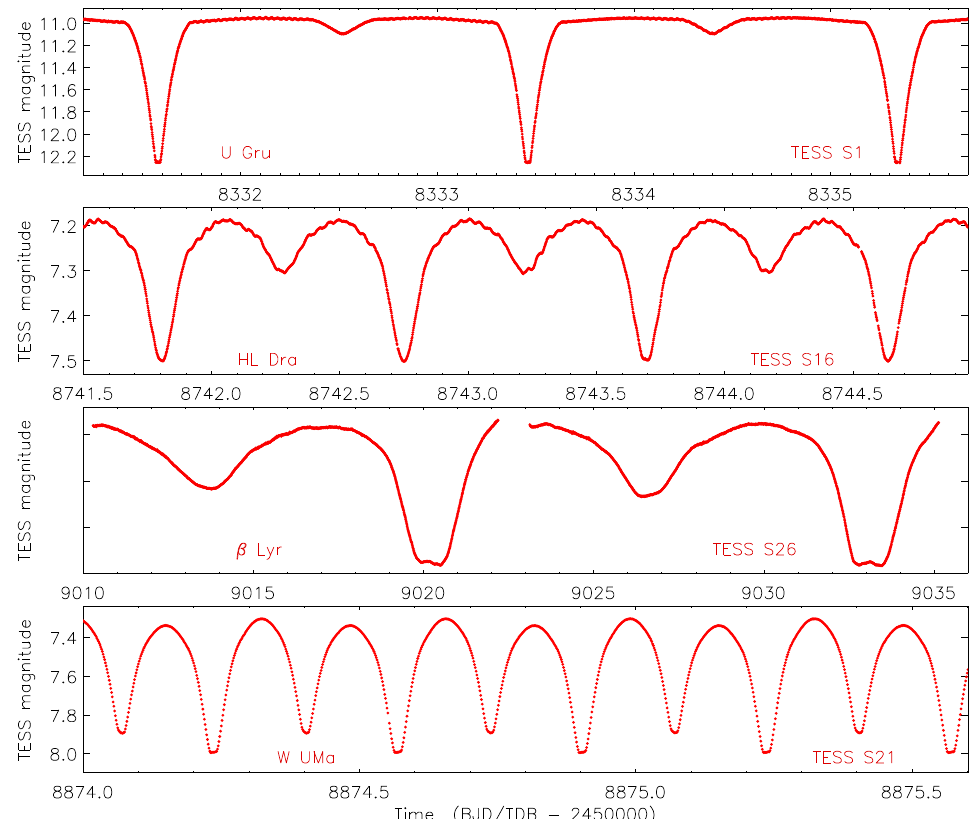
Figure 9. Example TESS light curves of semi-detached and contact systems. The y -axis for β Lyr is not labelled as the eclipse depths in the TESS data are